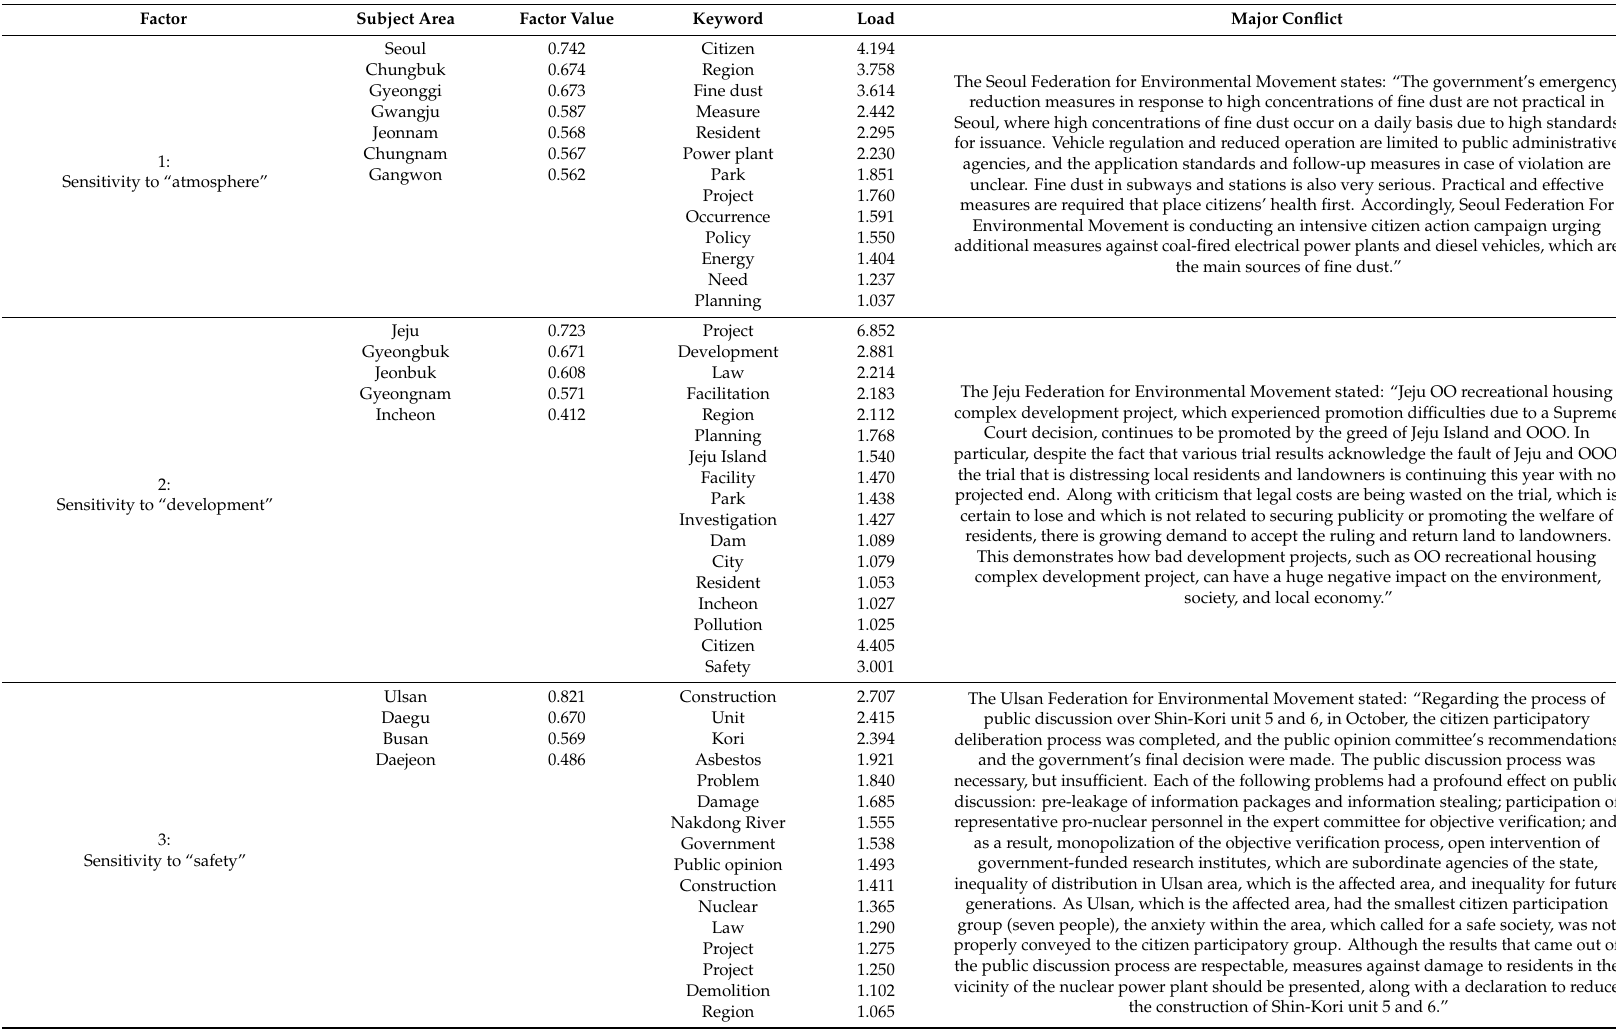
Table 3. Main extracted keywords (with a factor value ≥ 2) and distribution of subject areas by factor